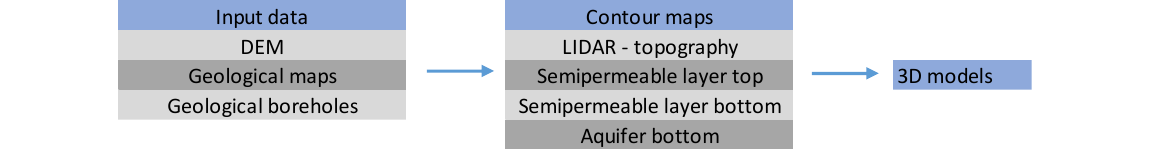
Figure 3. The modelled bottom impermeable layer of Quaternary aquifers.